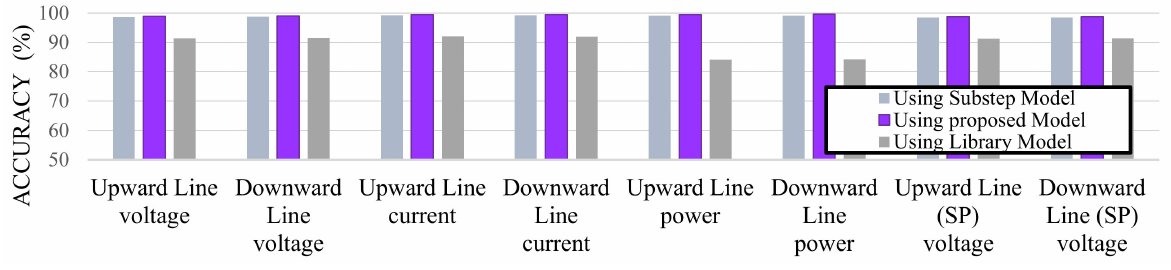
Figure 16. Comparison of accuracy between the simulation results of each model and the actual measurement